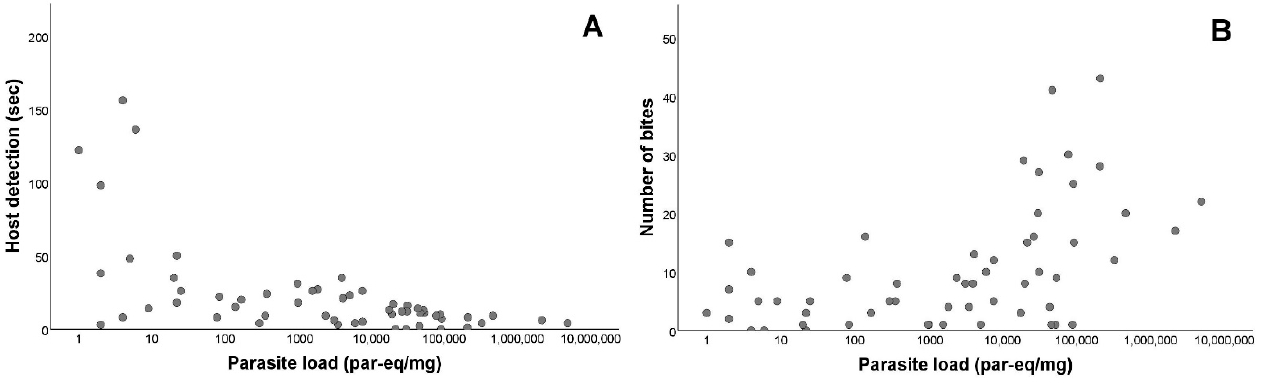
Figure 3. Feeding activity of Triatoma infestans according to Trypanosoma cruzi parasite load. ( A ) Parasite load (LOG 10 ) in relation to host detection time, in seconds. Host detection is defined as the time elapsed since the triatomine begins to mobilize in the arena until the moment when the insect starts walking towards the host. ( B ) Parasite load (LOG 10 ) in relation to the number of bites performed by the vector. Number of bites is defined as the total number of bites performed.